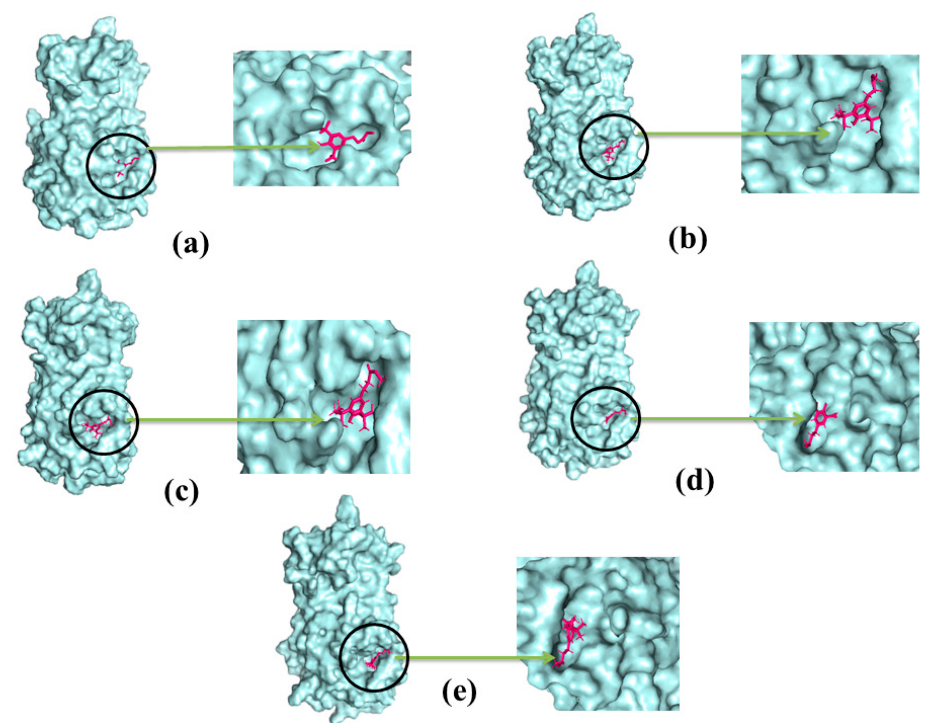
Figure 8. The simulation snapshots of hydrocinnamic acid and main protease complex acquired from the trajectories where rigid profiles of the ligand-protein complex were observed in the same binding pockets. The snapshots were ( a – e ) taken after 0, 25, 50, 75, and 100 ns intervals, respectively.